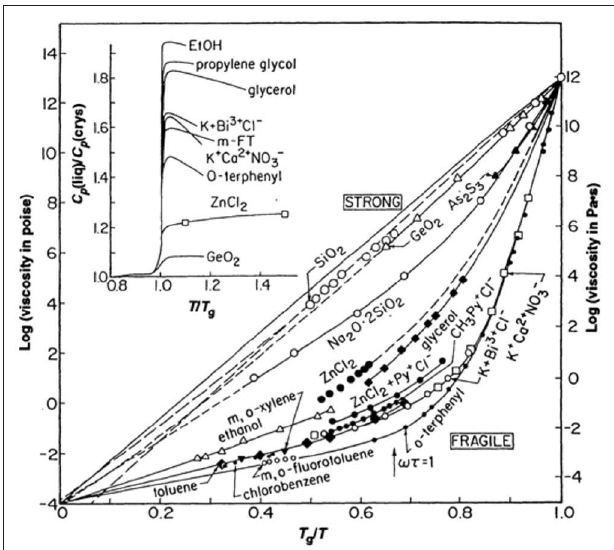
FIGURE 1 | Fragility plot as originally published (Angell, 1984). The viscosity of a variety of glass-forming melts is plotted against inverse temperature scaled to the glass transition temperature where the viscosity equals 10 12 Pa s. Inset illustrates the jump in specific heat of selected melts which is partly correlated to the degree of fragility from ( Angell, 1991) with